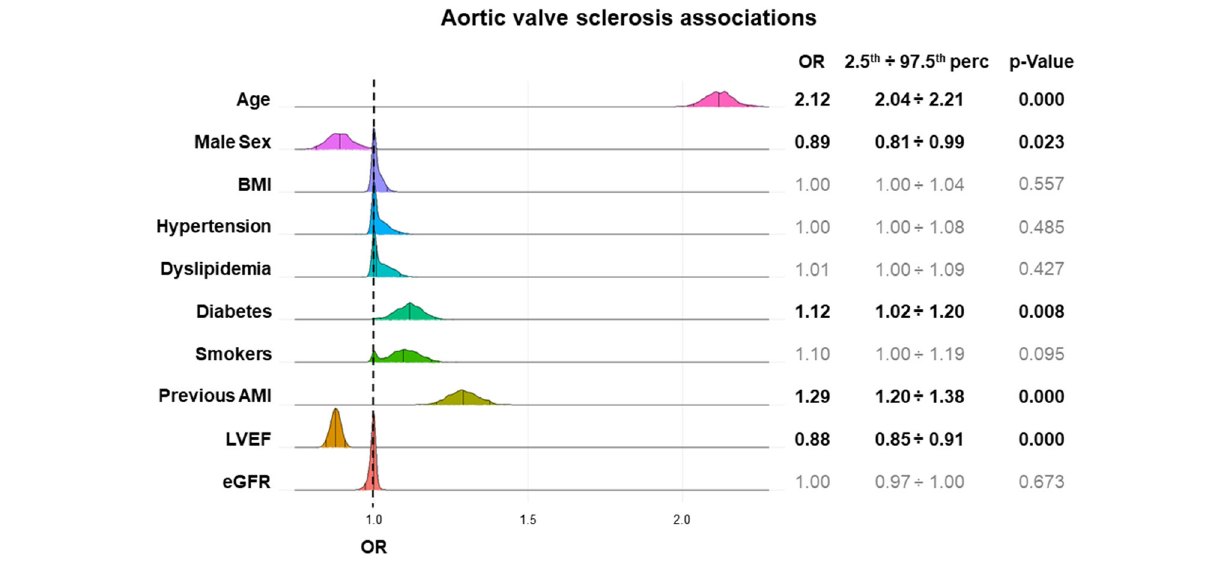
FIGURE 2 | AVSc associations in high-risk CAD patients. The plot shows the strength of the associations between cardiovascular risk factors and AVSc (odds ratio–OR) and their dispersion. For each variable, the results obtained from multivariable logistic LASSO regressions after 1,000 bootstrap iterations are depicted and the OR (median, 2.5th percentile, and 97.5th percentile) and significance level are reported. The y-axis represents the frequency of a specific OR, while the x-axis represents the OR estimated values. AMI, acute myocardial infarction; BMI, body mass index; CAD, coronary artery disease; eGFR, estimated glomerular filtration rate; LVEF, left ventricular ejection